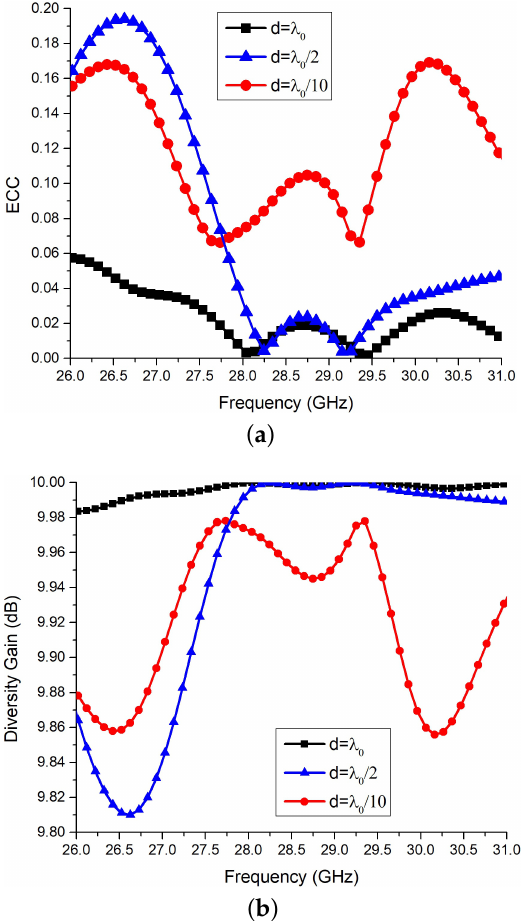
Figure 9. Simulated performance characteristics of MIMO-1. ( a ) ECC ( b ) DG .